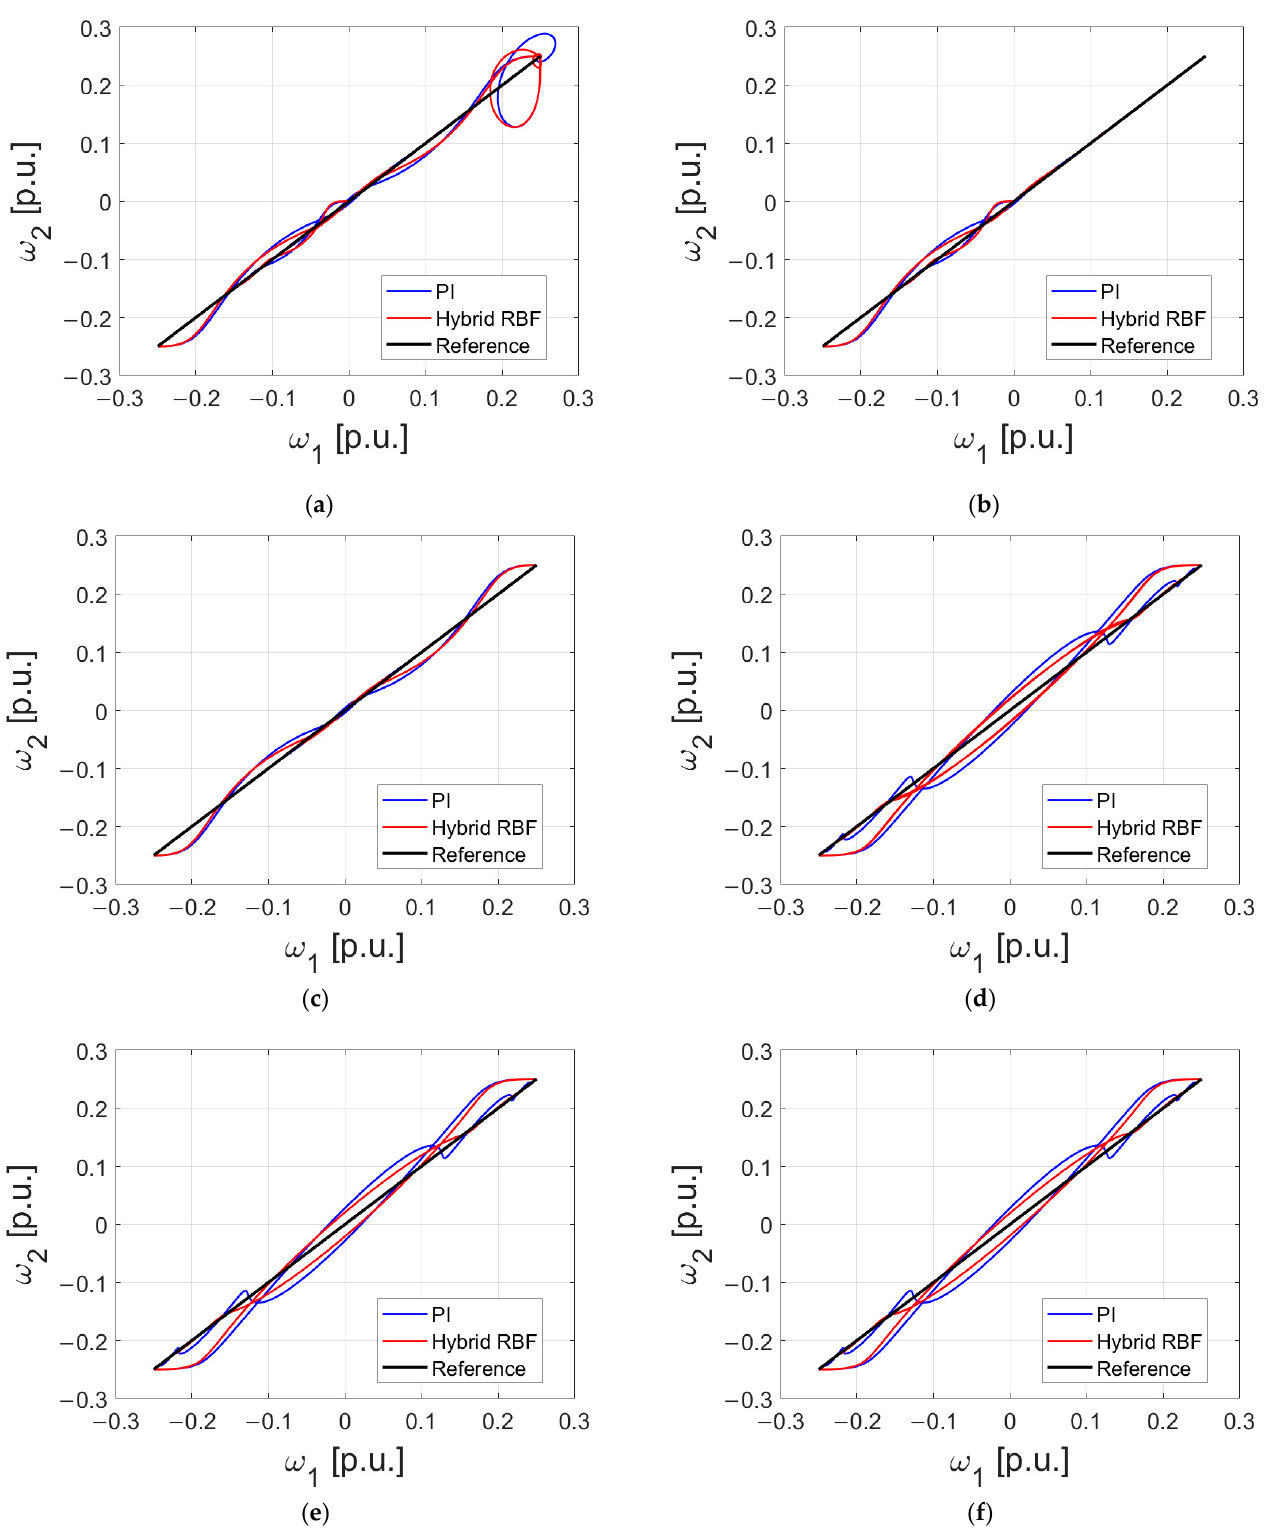
Figure 7. Simulation results: the correlation between the rotational speeds of the load and the motor: before the change of T 2 : ( a ) the whole duration of the simulation; ( b ) time between 0–10 s; ( c ) time between 20–30 s; with the increased value of T 2 : ( d ) the whole duration of the simulation; ( e ) time between 0–10 s; ( f ) time between 20–30 s.